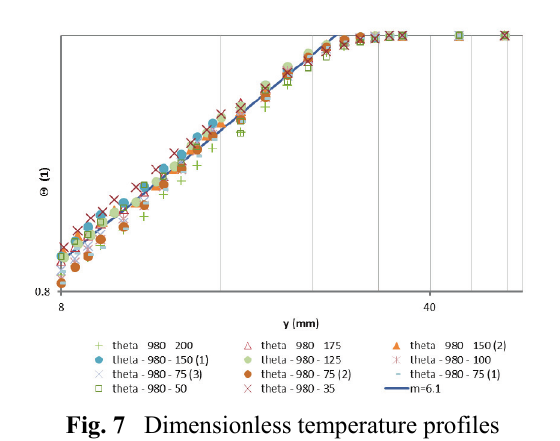
re plotted for x= 900 mm and x= 980 mm. At